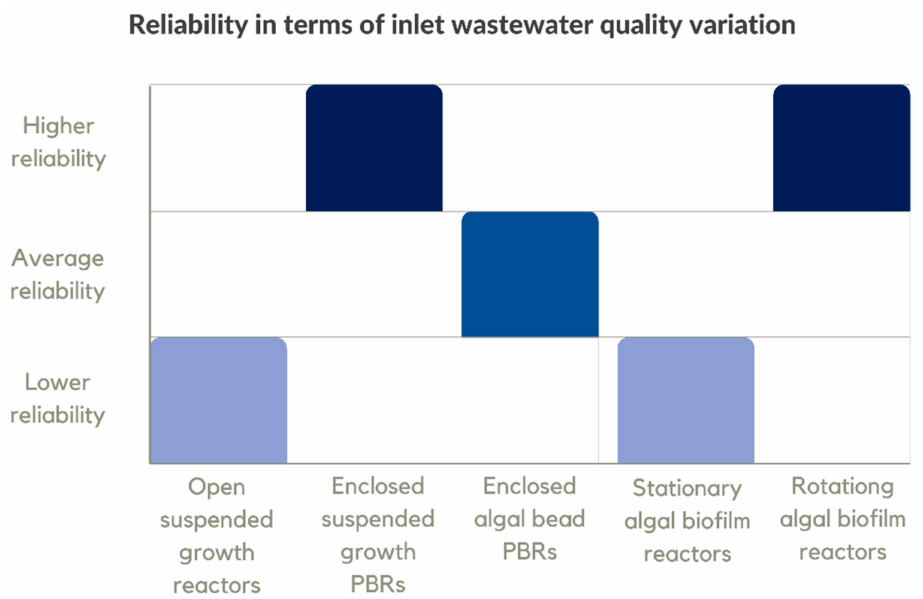
Figure 8. Reliability of the available algae-based wastewater treatment reactor configurations in terms of wastewater quality